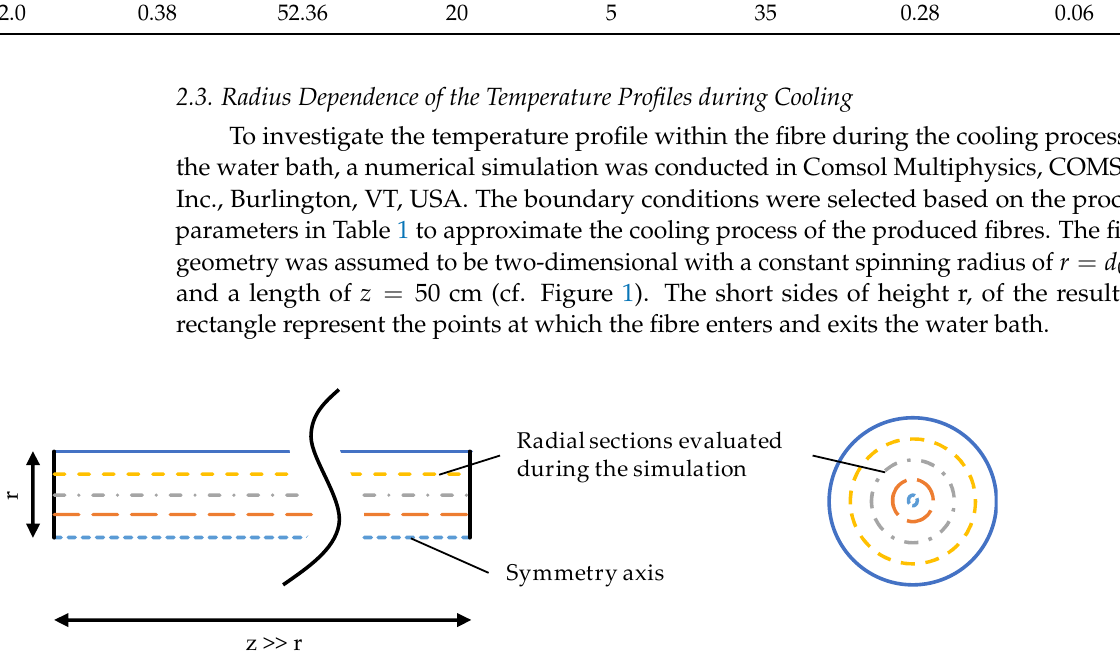
Figure 1. Simplified two-dimensional fibre geometry investigated by numerical simulation (left) and schematic illustration of radial sections evaluated during the simulation.